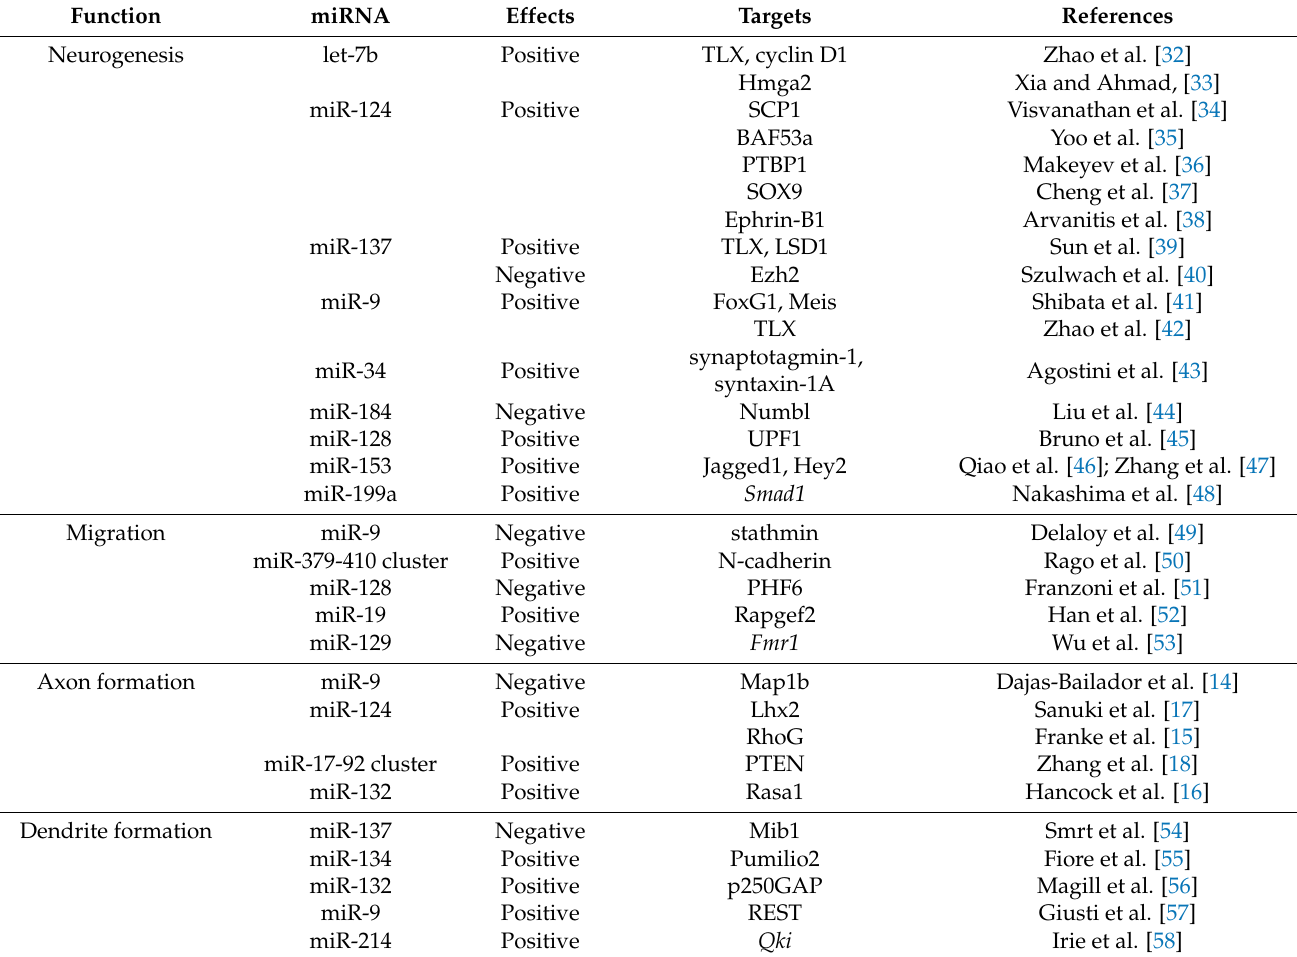
Table 1. microRNAs (miRNAs) involved in brain